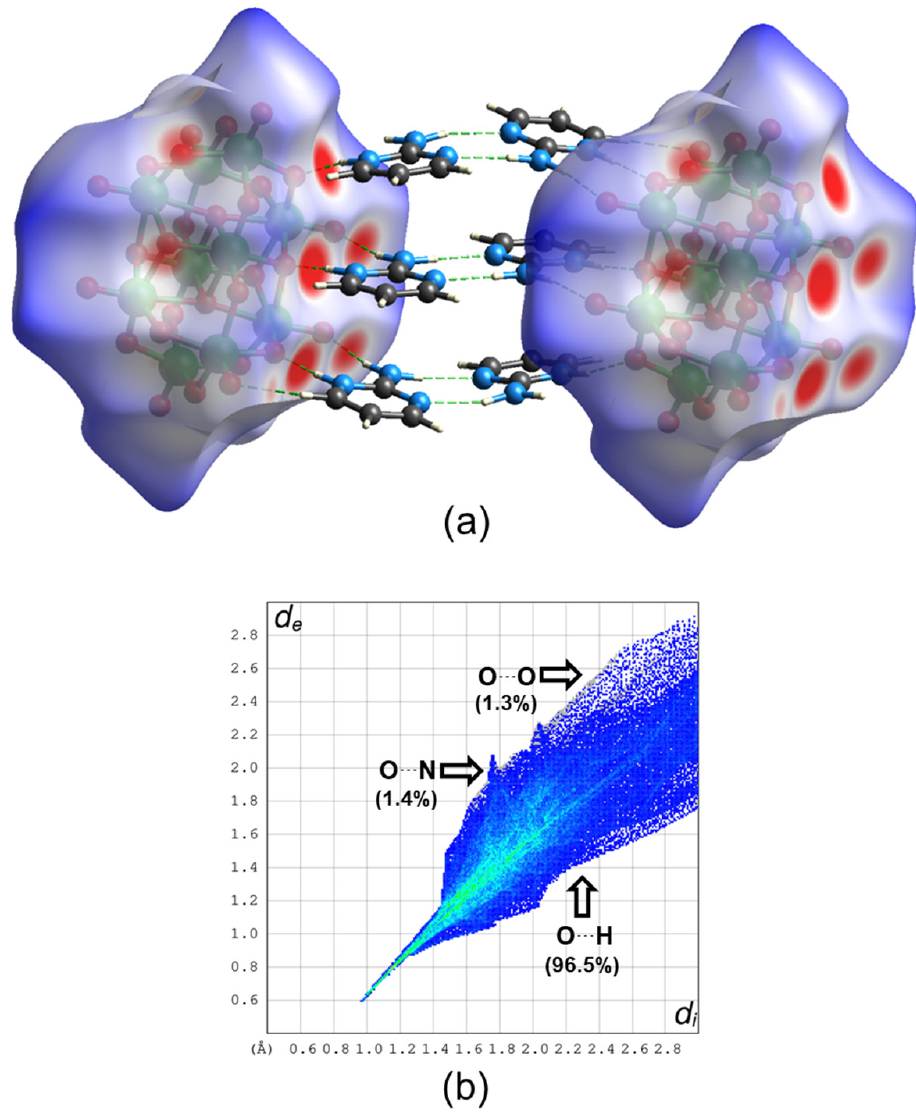
Figure 10. ( a ) Hirshfeld surface mapped with d norm parameter for Compound 1 and ( b ) fingerprint plot of non-covalent interactions. In ( a ) red spots represent close intermolecular interactions and green dash lines represent hydrogen bonds. In ( b ) blue-green region represent the contribution to the total area of the surface